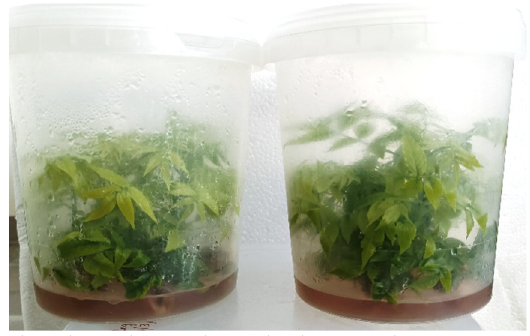
Figure 2. In vitro cultured explants during the multiplication phase Root induction : ‘Vlach’ explants collected during the multiplication phase were cultured in DKW medium [5], with ½ macronutrients and 96 mg L − 1 Fe-EDDHA, added with 3 mg L − 1 IBA, 30 g L − 1 sucrose, and 100 mg L − 1 hydrolyzed casein and gelled with 2.5 g L − 1 Gellan Gum ® . The pH was adjusted to 5.5 before autoclaving.